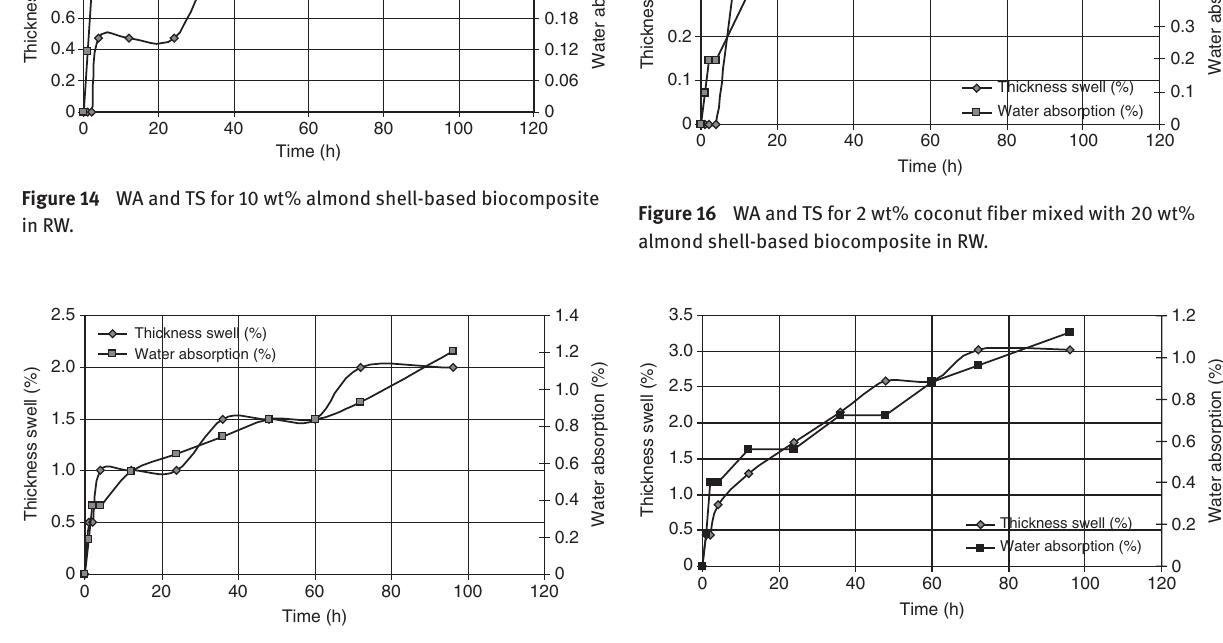
Figure 15 WA and TS for 50 wt% almond shell-based biocomposite in RW.